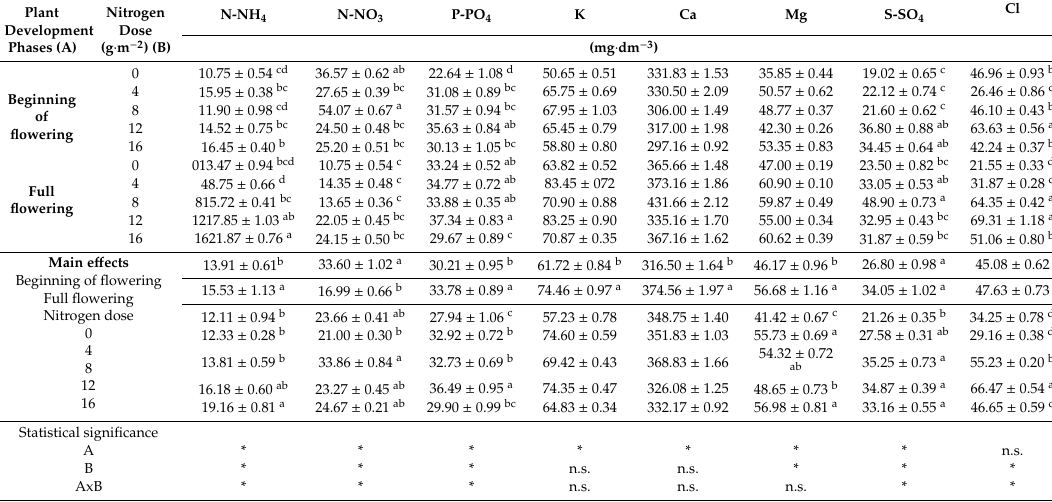
Table 4. Nutrient content in the soil after the summer savory harvest (in 2014–2016) (Note: For an explanation, see Table